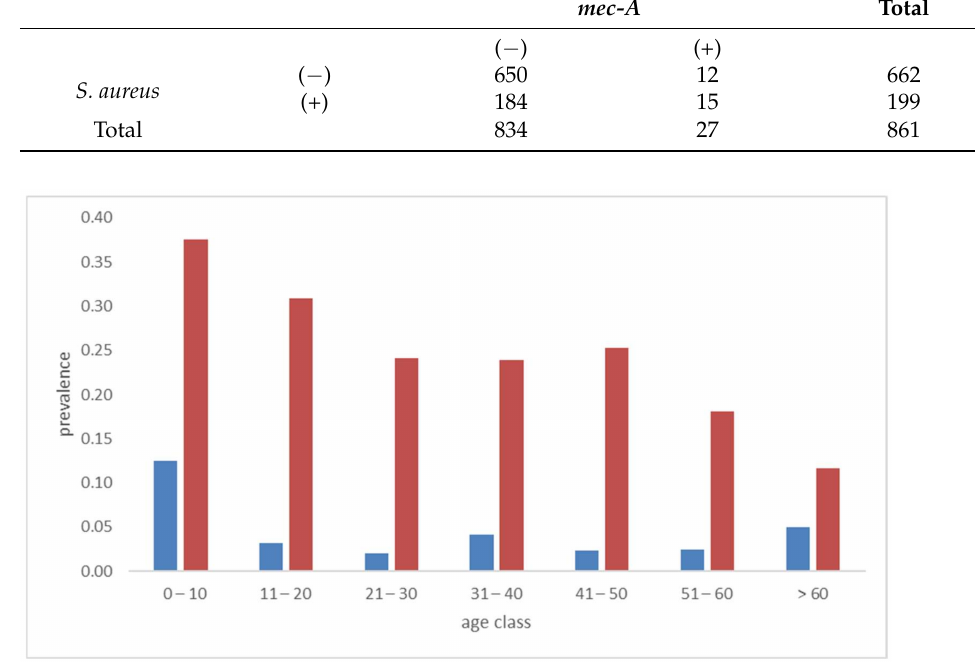
Figure 2. Prevalence of S. aureus (red bars) and mec-A gene (blue bars) in the different age class. Table 3. Occurrence of S. aureus and mec-A stratified by sex, smoking habits and alcohol consumption. S.